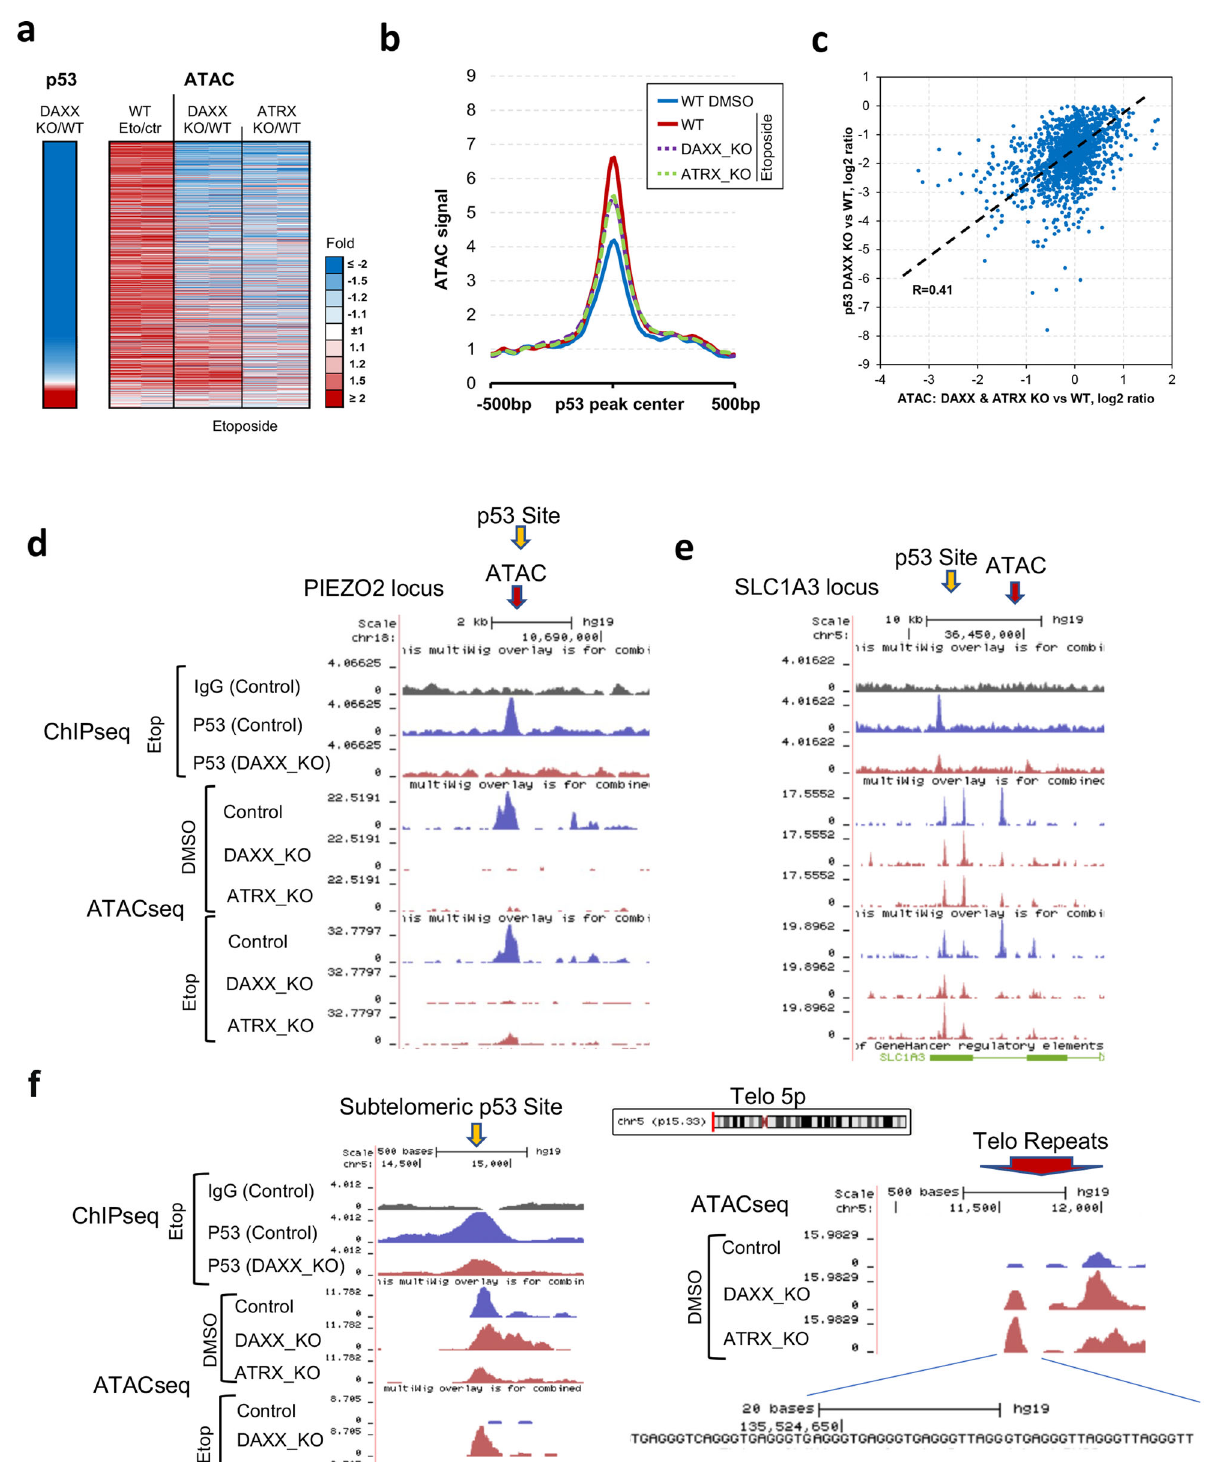
Fig. 5 | p53 binding correlates with ATAC-Seq changes. a Heatmap of ATAC changes at p53 ChIP-seq binding sites, sorted by p53 ChIP-seq signal changes in DAXXKOrelativetoWT(left).DAXXandATRXKOaresimilarlydownregulatedfor open chromatin at p53-binding sites. b Line graph showing average ATAC signal around p53 peaks demonstrates upregulation upon etoposide treatment in WT, and that signal gets attenuated in DAXX and ATRX KO. c Scatter plot showing a